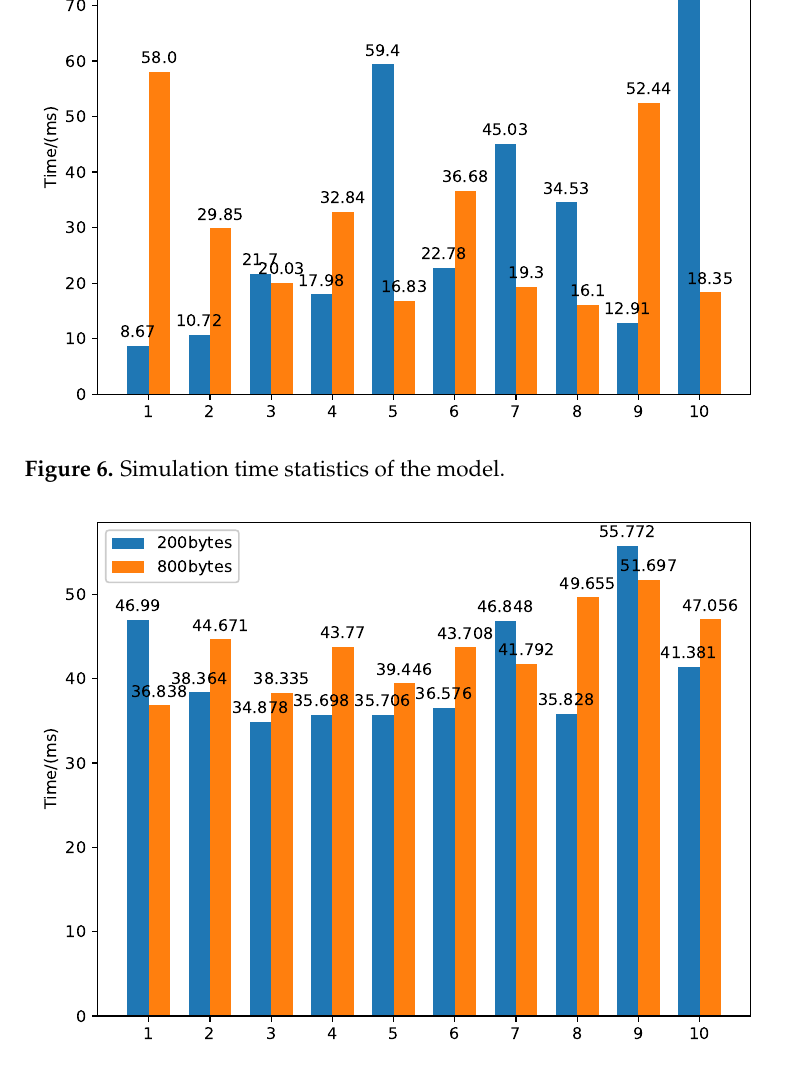
Figure 7. Simulation time statistics of the attack. Table 7. Result of the comparison with other